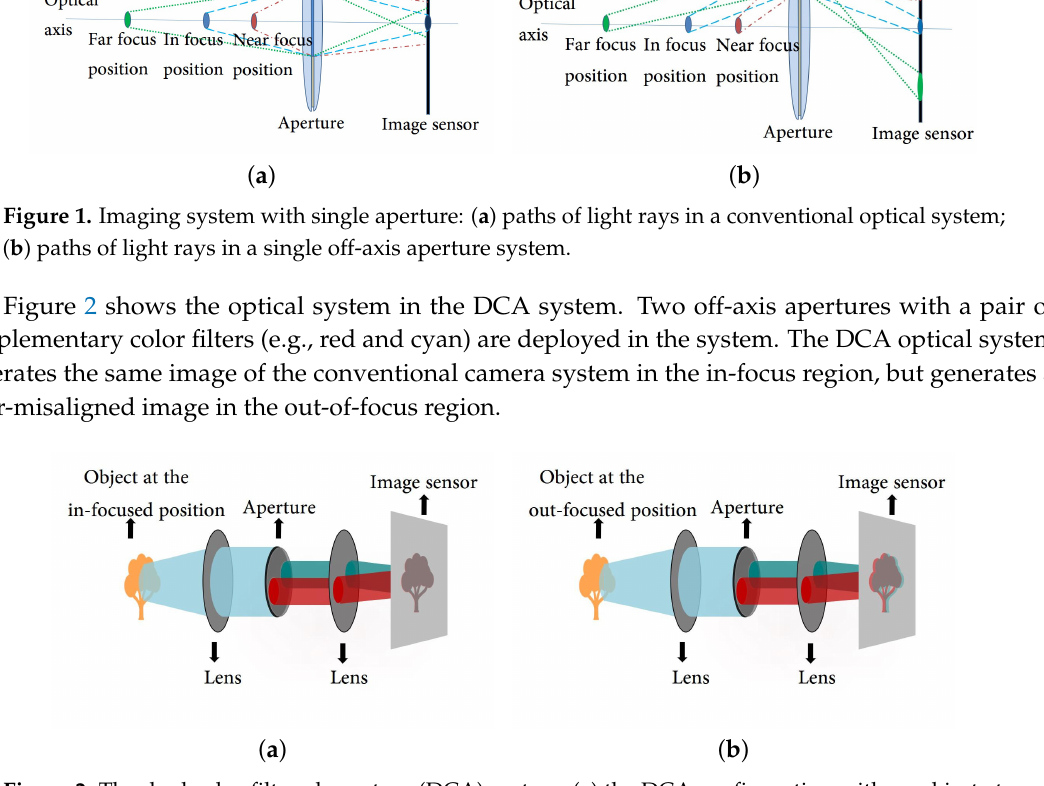
Figure 2. The dual color-filtered aperture (DCA) system: ( a ) the DCA configuration with an object at the in-focus position; and ( b ) the DCA configuration with an object at the out-of-focus